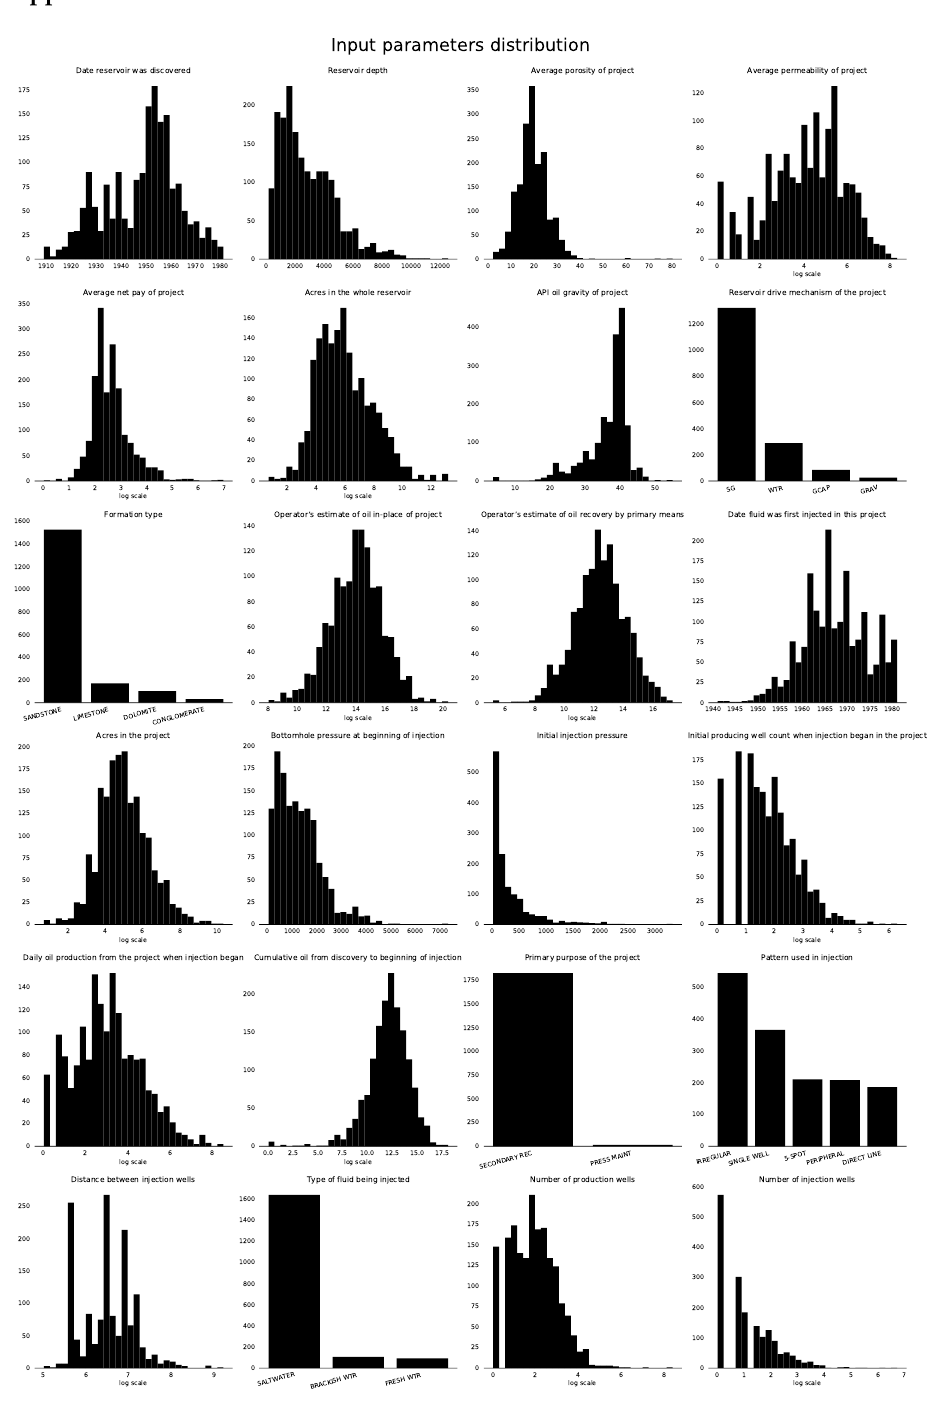
Figure A1. Input parameters